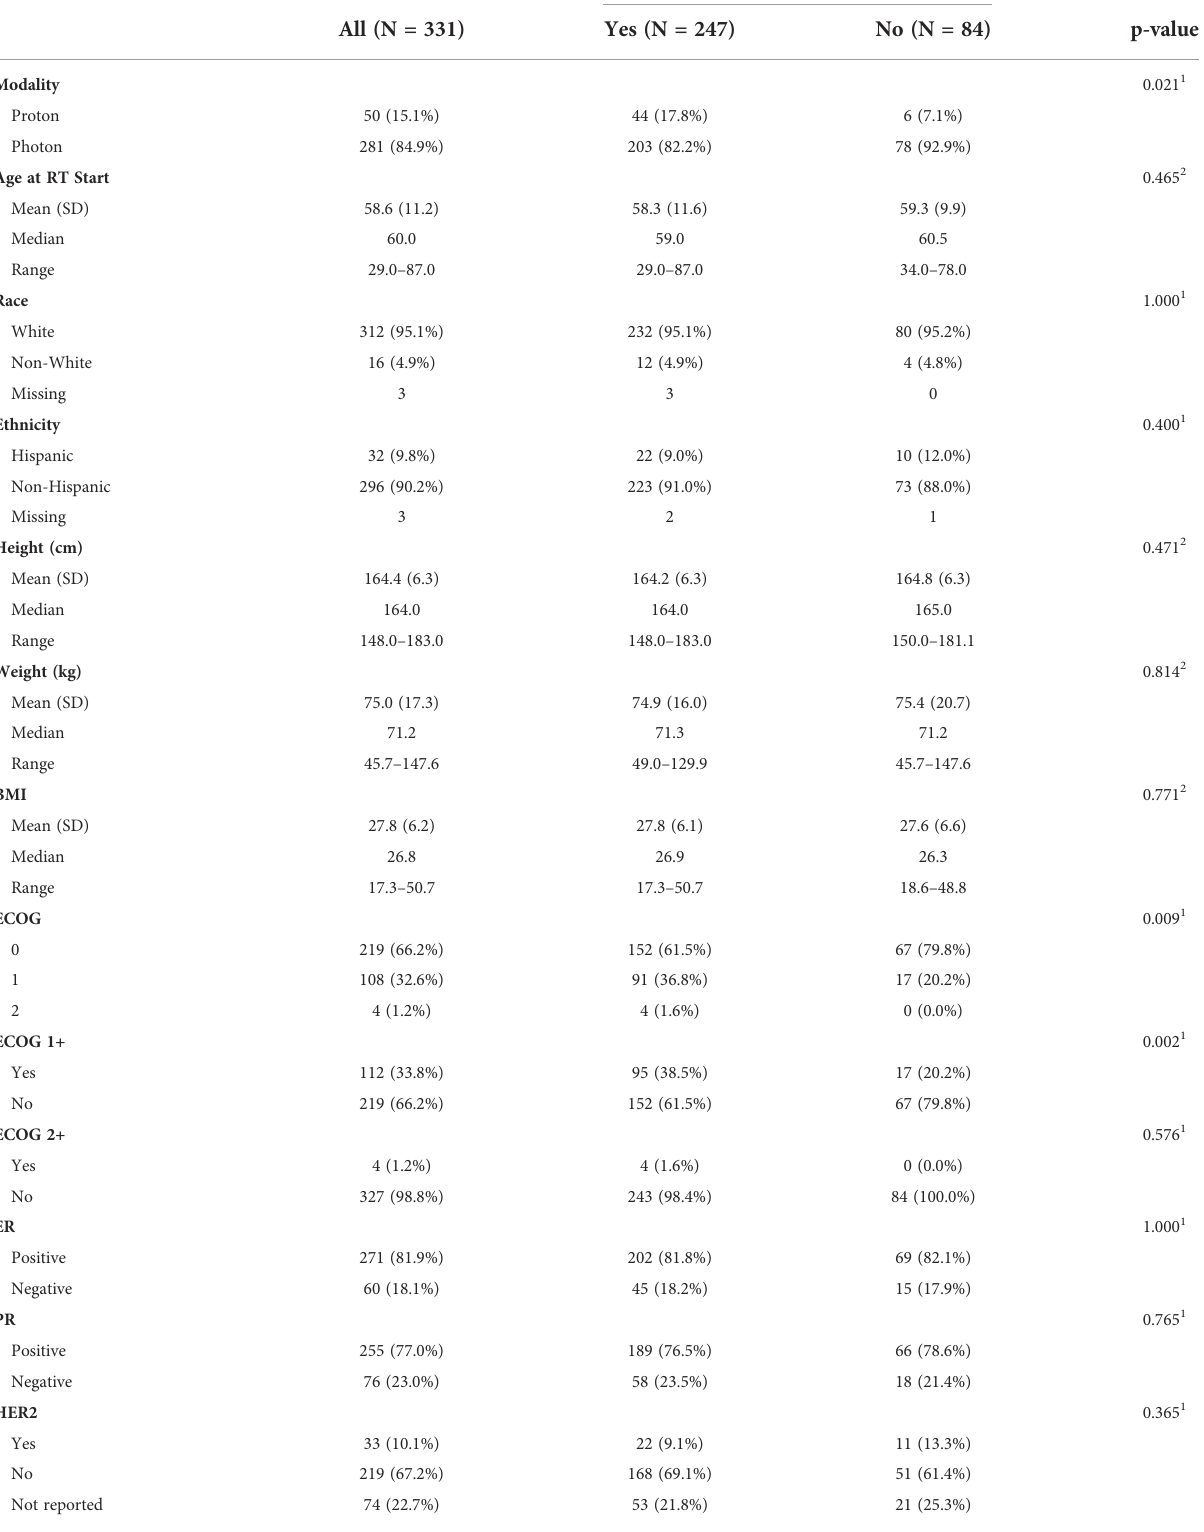
TABLE 2 Patient characteristics by patients with any grade 2+ PRO